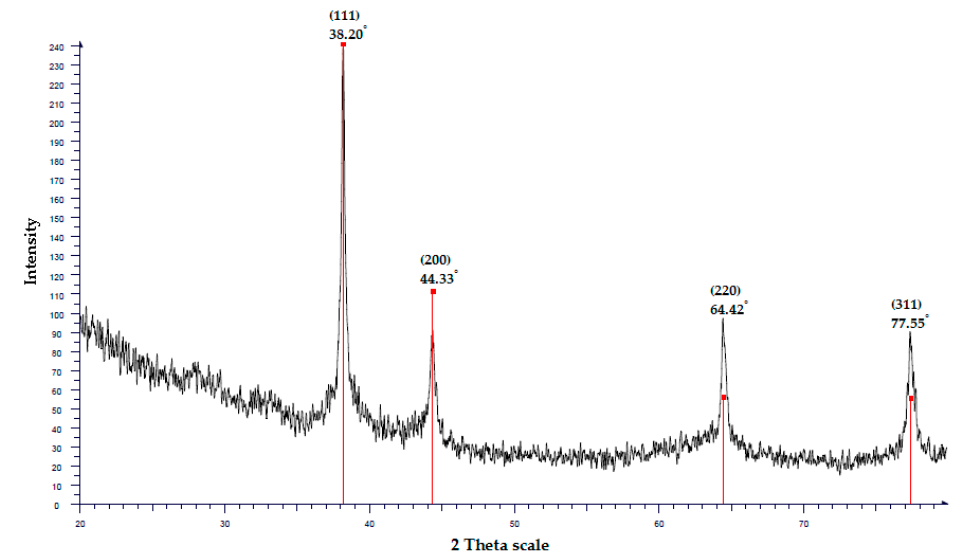
Figure 3. X-ray diffraction (XRD) pattern of AgNPs synthesized using C. zedoaria oil (ZEO-AgNPs).